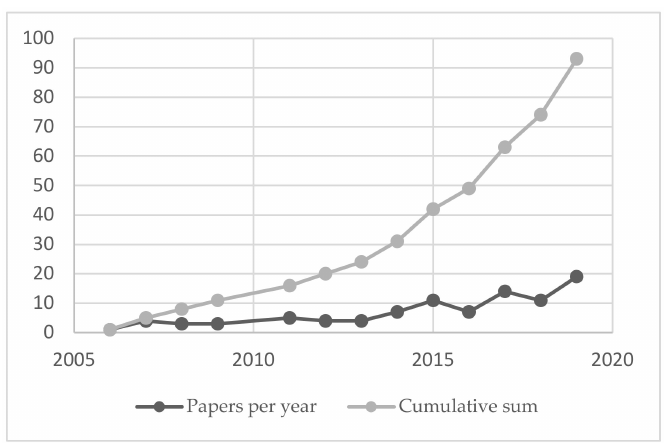
Figure 2. Number of papers published per year and their respective cumulative